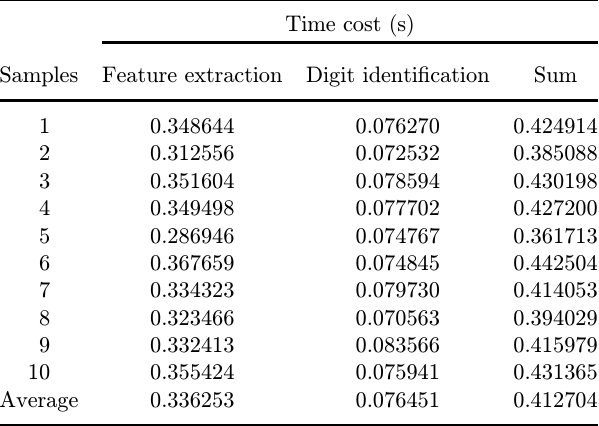
Table 1. Computation cost of the identi¯cation